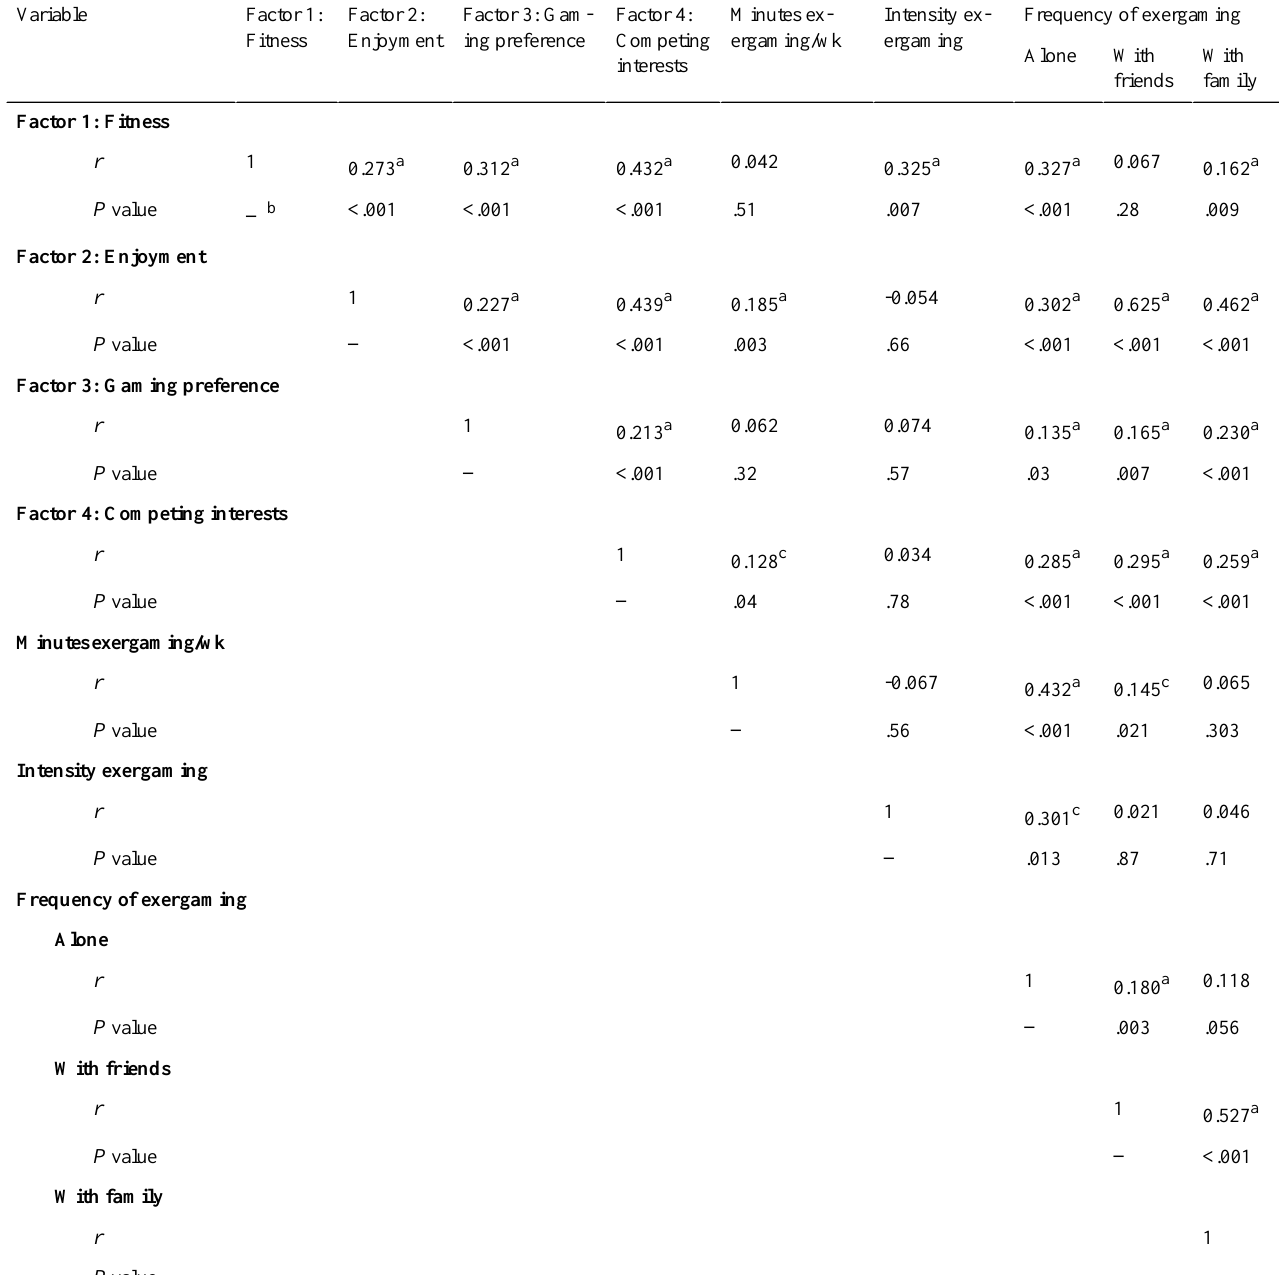
Table 4. Correlations among variables used in the regression models in Study 1, NDIT